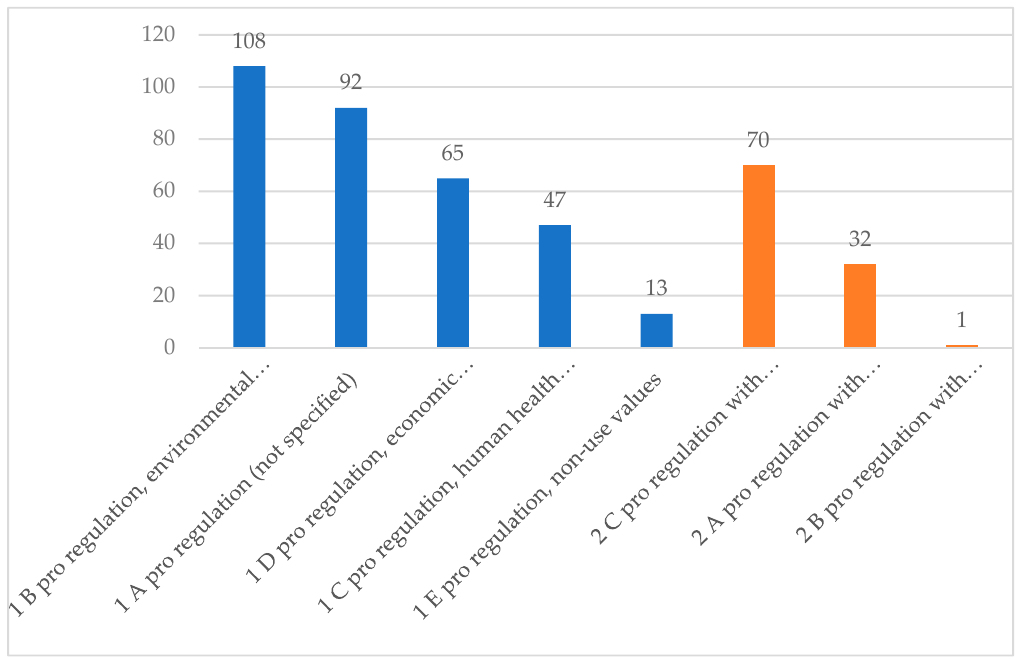
Figure 1. Coding units per sub-category for category 1 (pro regulation) and category 2 (pro regulation with reservations).